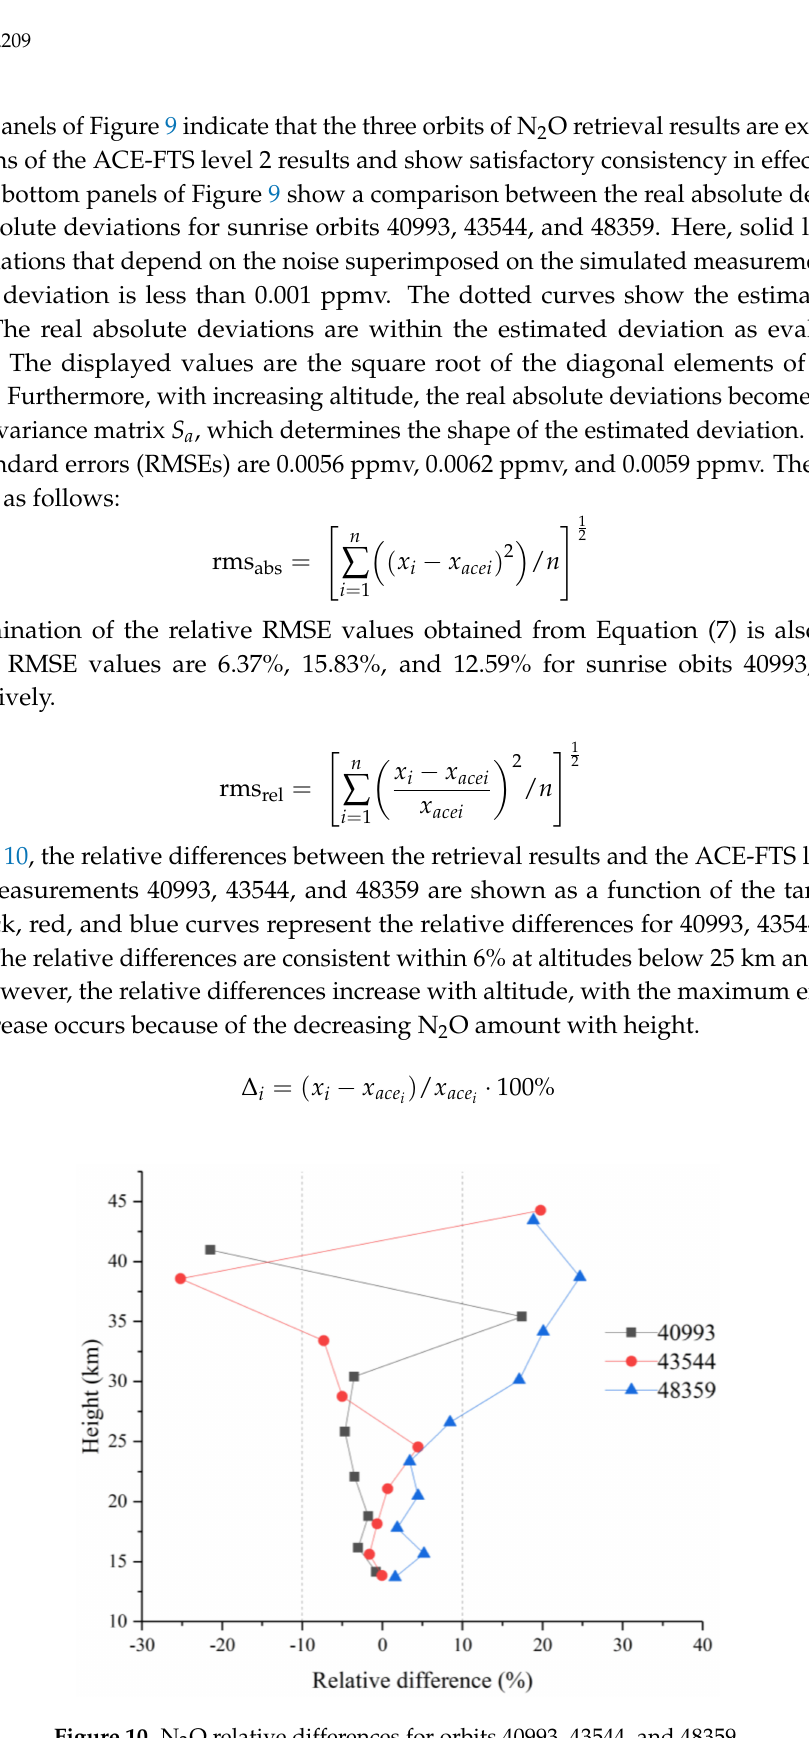
Figure 10. N 2 O relative differences for orbits 40993, 43544, and